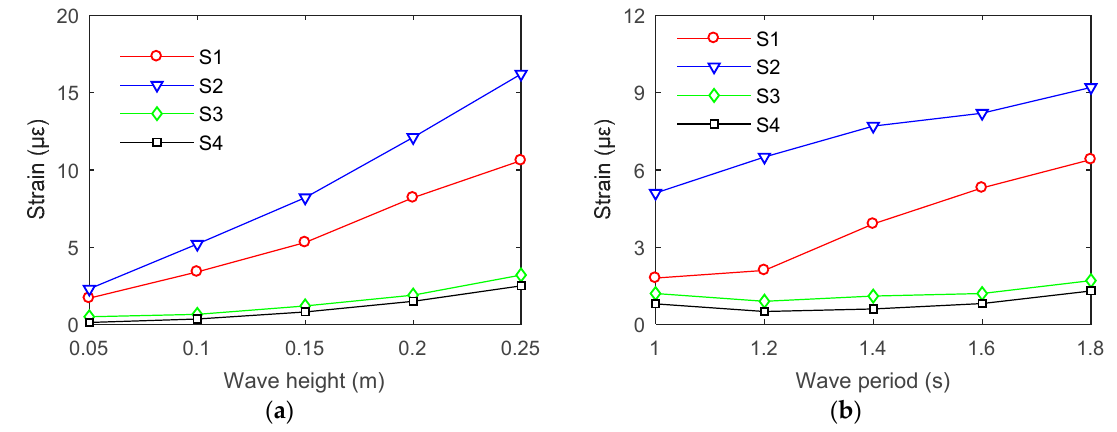
Figure 8. The structural strains at various measurement positions in waves. ( a ) Variation with wave height when wave period T = 1.6 s; ( b ) Variation with wave period when wave height H = 0.15